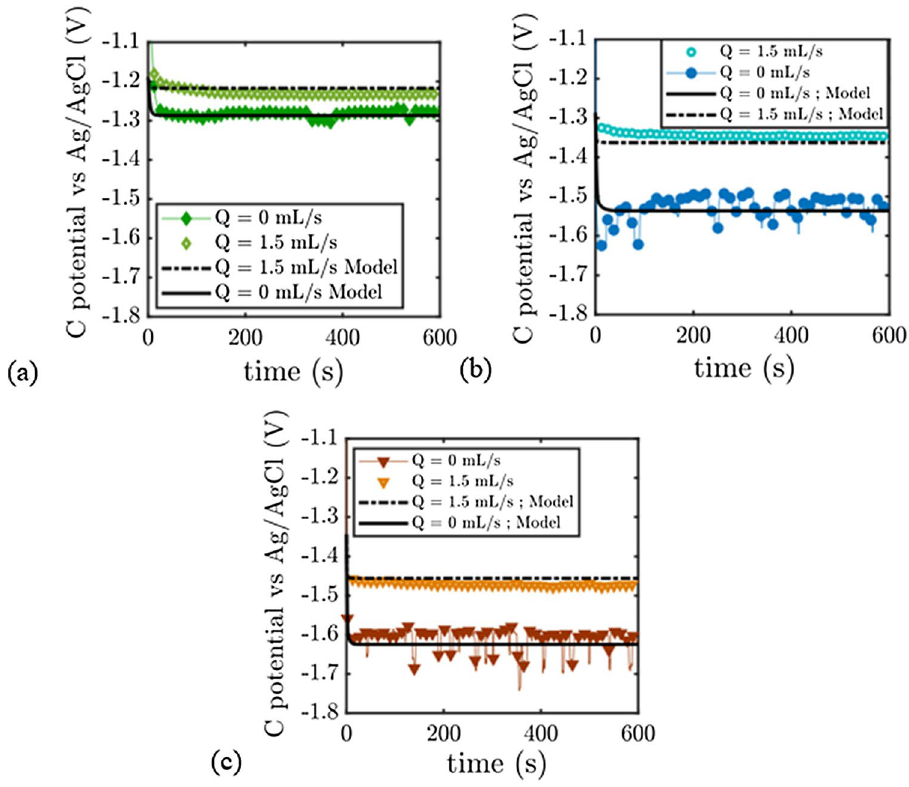
Figure 5. Chronopotentiometry of the carbon electrode versus Ag/AgCl electrode during OER in 8M KOH/1M zincate electrolyte. ( a ) j = −3 mA/cm 2 . ( b ) j = − 10 mA/cm 2 . ( c ) j = − 20 mA/cm 2 .